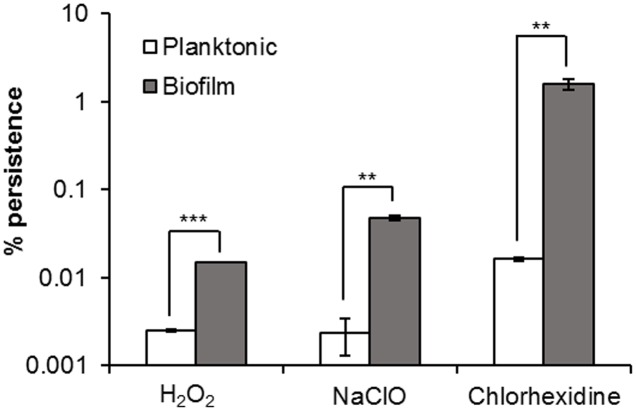
Persister cells in H. volcanii biofilms. Comparison of percentage survival of planktonic and biofilm cultures of H. volcanii, following incubation for 6 h in biocidal concentrations of H2O2, NaClO, and chlorhexidine. Plotted values are the mean of triplicate measurements and error bars represent ± SD. Asterisks denote significance values as determined by paired t-tests: ∗p < 0.05; ∗∗p < 0.01; ∗∗∗p < 0.001.